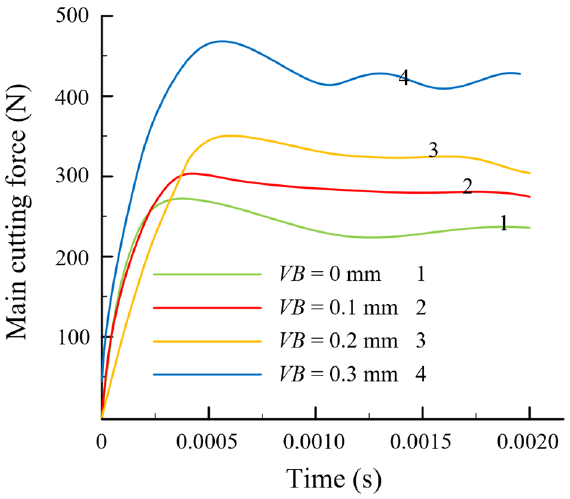
Figure 3. Simulation results for cutting force.